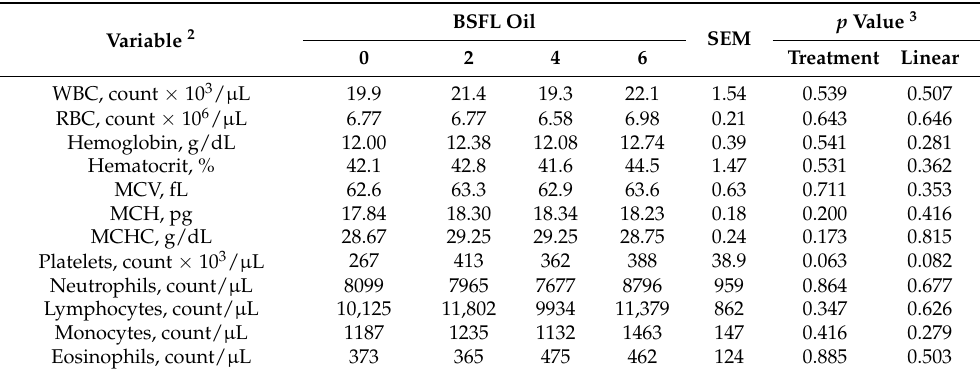
Table 6. Effects of black soldier fly larvae (BSFL) oil replacing equal amounts of corn oil on complete blood counts in nursery pigs 1